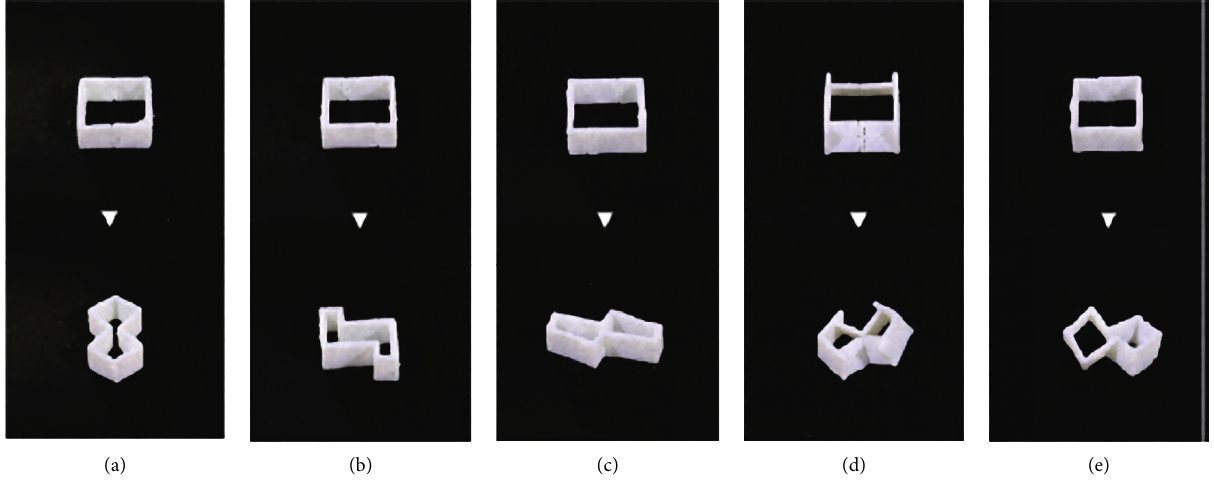
Figure 2: Auxetic modules developed in